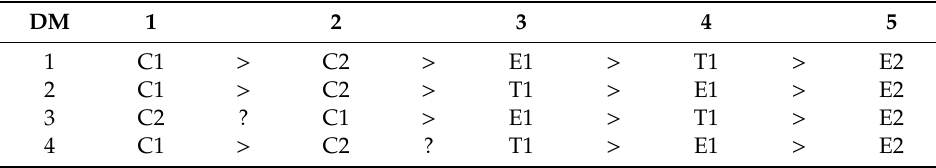
Table 6. Order of preference for criteria given by